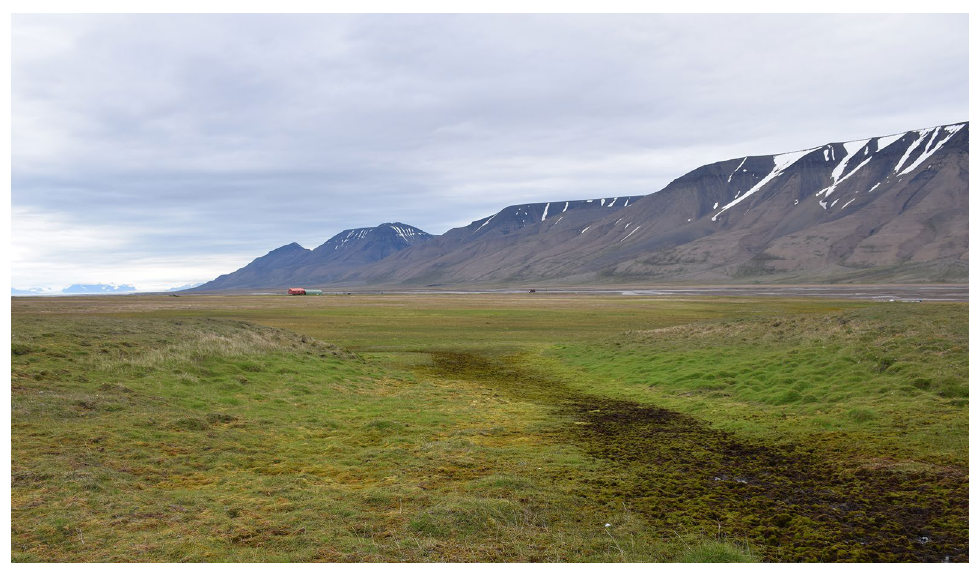
Figure 3. The general view of the Bolterdalen study site. Similar to Bjørndalen, variations between wet and dryer microforms of landscape can be